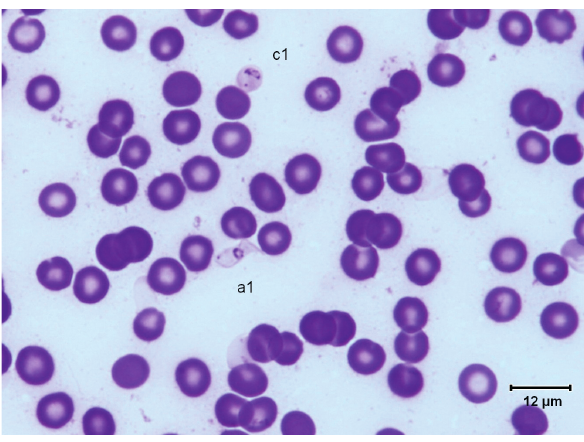
Fig. 8. – One T. (Nannomonas) isomorph ( congolense -form) (b1) and several forms intermediary between hyperpachymorph and sphaeromorph (ac1). Photo by Marc Desquesnes. Intermediary forms suggest an “S” folding of the parasite on itself like a collapsible tent